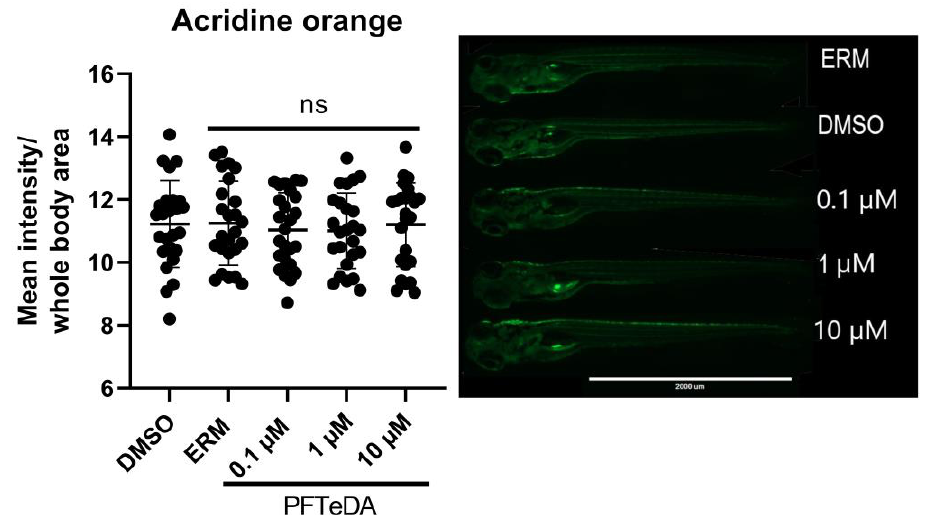
Figure 4. Acridine orange (apoptosis) staining in larval zebrafish treated with ERM, 0.1% DMSO, 0.1 µ M, 1 µ M, and 10 µ M PFTeDA. Each point is a biological replicate and the horizontal line indicates the mean value of the group (mean ± S.D.) (one-way ANOVA followed by a Dunnett’s multiple comparisons test, n = 25/group).